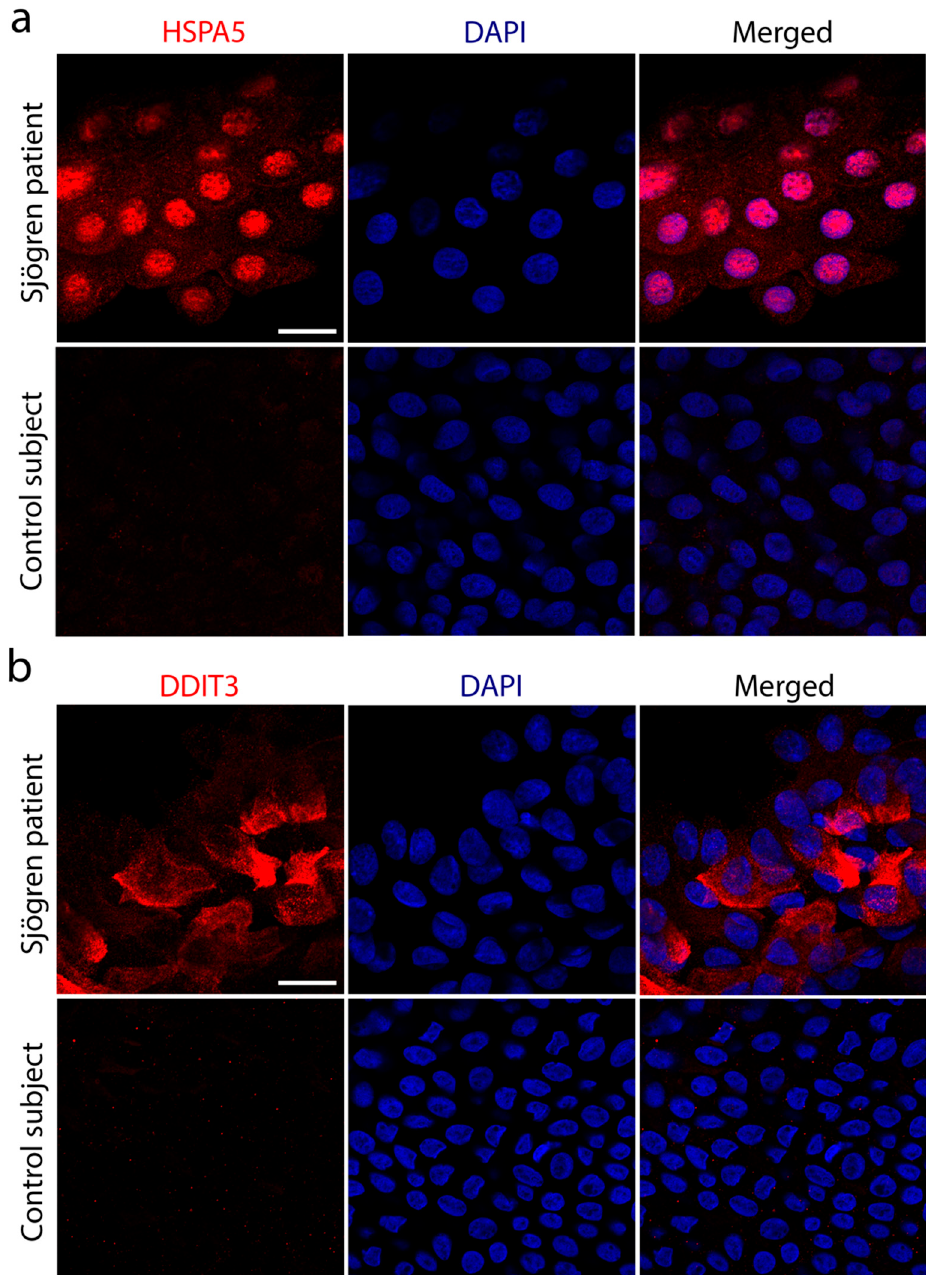
Figure 1. Expression of indicators of cells undergoing ER stress in conjunctival epithelium of patients with Sjögren’s syndrome and control subjects. Conjunctival impression cytology samples were collected from the superior and temporal bulbar conjunctiva. Cells in the filters were immunostained with antibodies against HSPA5 ( a ) or DDIT3 ( b ), and counterstained with DAPI. Scale bars: 20 µm.